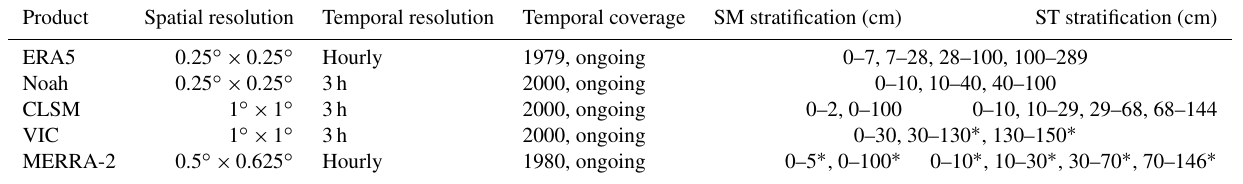
Table 3. Information on the selected model-based